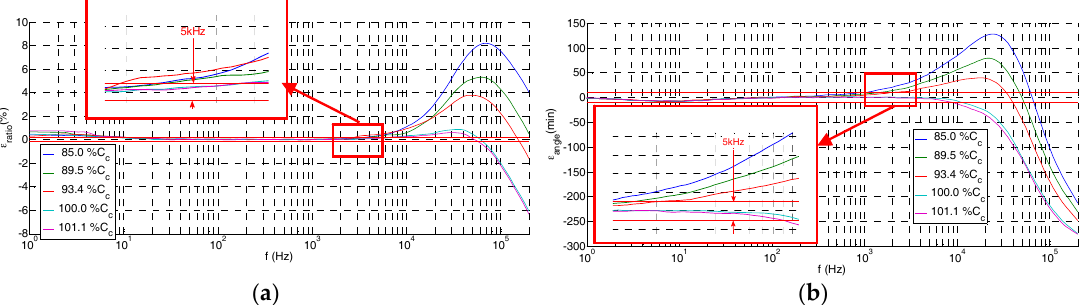
Figure 6. Measured errors in the real design of Figure 1 due to the difference in the length of coaxial cable C c with respect to the theoretical value: ( a ) ratio error; ( b ) phase displacement error. In the low frequency range (1–10 Hz), the rated ratio of the divider increases up to 0.7% (see Figure 7), while the angle error maintains lower than 10 min for the C c values analyzed (85.0–101.1% C c ).